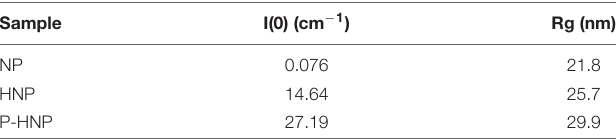
TABLE 4 | Values of X-ray scattering intensity in the origin [I(0)] and radius of gyration (Rg) of NP , HNP , and P-HNP .